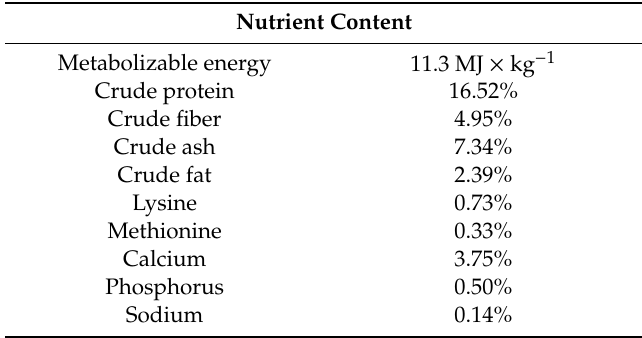
Table 2. Nutrient content of the basal diet.